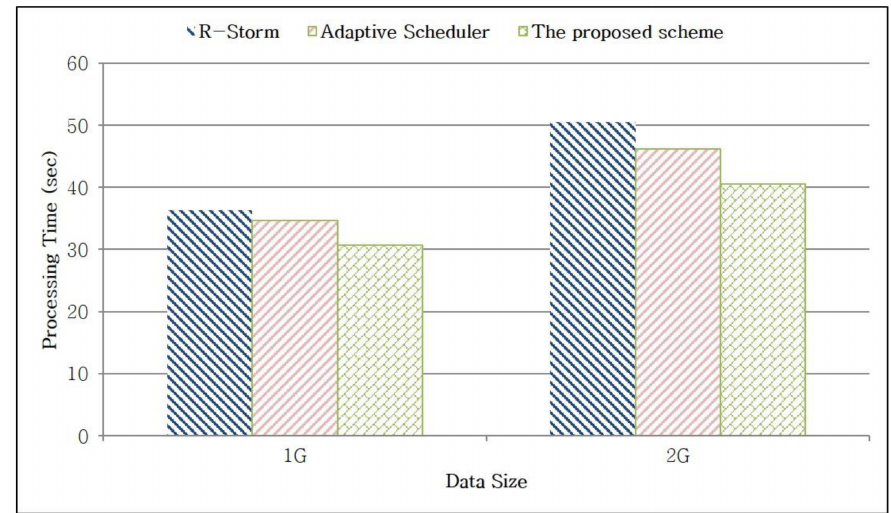
Figure 9. Query processing time based on data size.